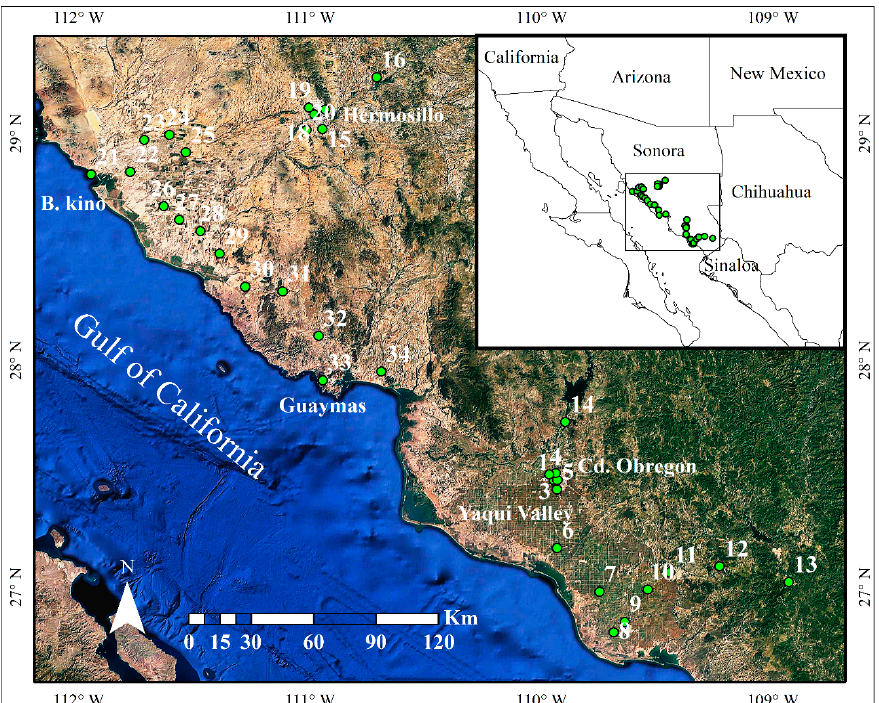
Figure 1. Study area in Sonora, Mexico. Green circles indicate the sites where buffelgrass was collected. Numbers indicate the collection site from small (sites 13 and 21), medium (9, 33 and 11) and large urban areas (1–4, 15, 17–19), agricultural (5–8, 10, 14, 16, and 24–30) and rural sites (20, 22, 23, 31, 32, and 34). Image data: Google Earth; date: 20 April 2020.